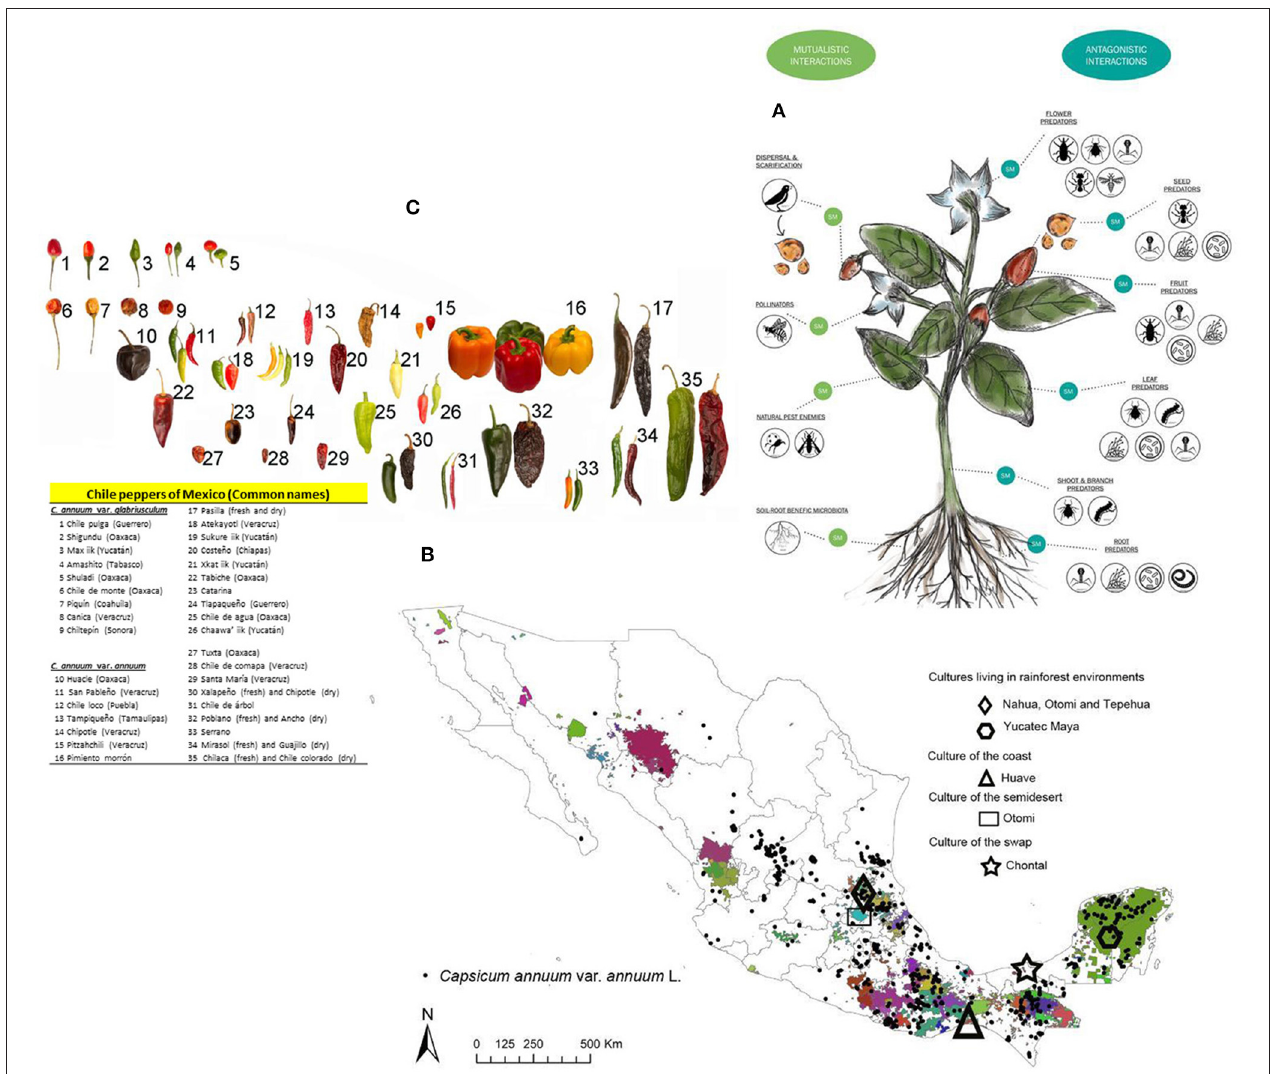
FIGURE 1 | Ecological and cultural interactions shaping diversity of chile peppers ( Capsicum annuum L.) across Mexico. (A) Graphic illustration of SMs as chemical mediators of ecological interactions with wild C. annuum in natural and semi-managed habitats. (Illustration designed by Frida Isabel Luna-Vallejo). (B) Map of Mexico showing indigenous territories, contrasted by colors. The symbols identify particular ecological zones where certain indigenous groups have persisted in modern times. All indigenous groups represented here have documented uses of chile peppers. (Map elaborated by Andres Lira Noriega and Araceli Aguilar-Melendez based on data from the authors, SINAREFI-SNICS-SAGARPA and SNIB/CONABIO 2016; the layer of indigenous territories was provided by Eckard Boege). (C) A representative sample of the wider array current morpho-typic diversity and levels of domestication of chile peppers across Mexico. (Photos by Ivan Montes de Oca Cacheux and Miguel Angel Sicilia Manzo/Image repository